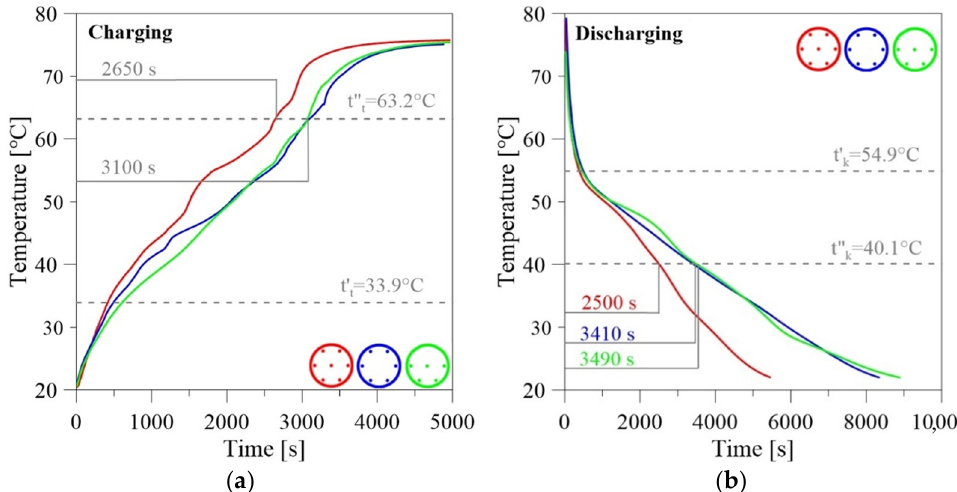
Figure 6. Effect of the number of tubes for LTP56: ( a ) charging; ( b ) discharging.